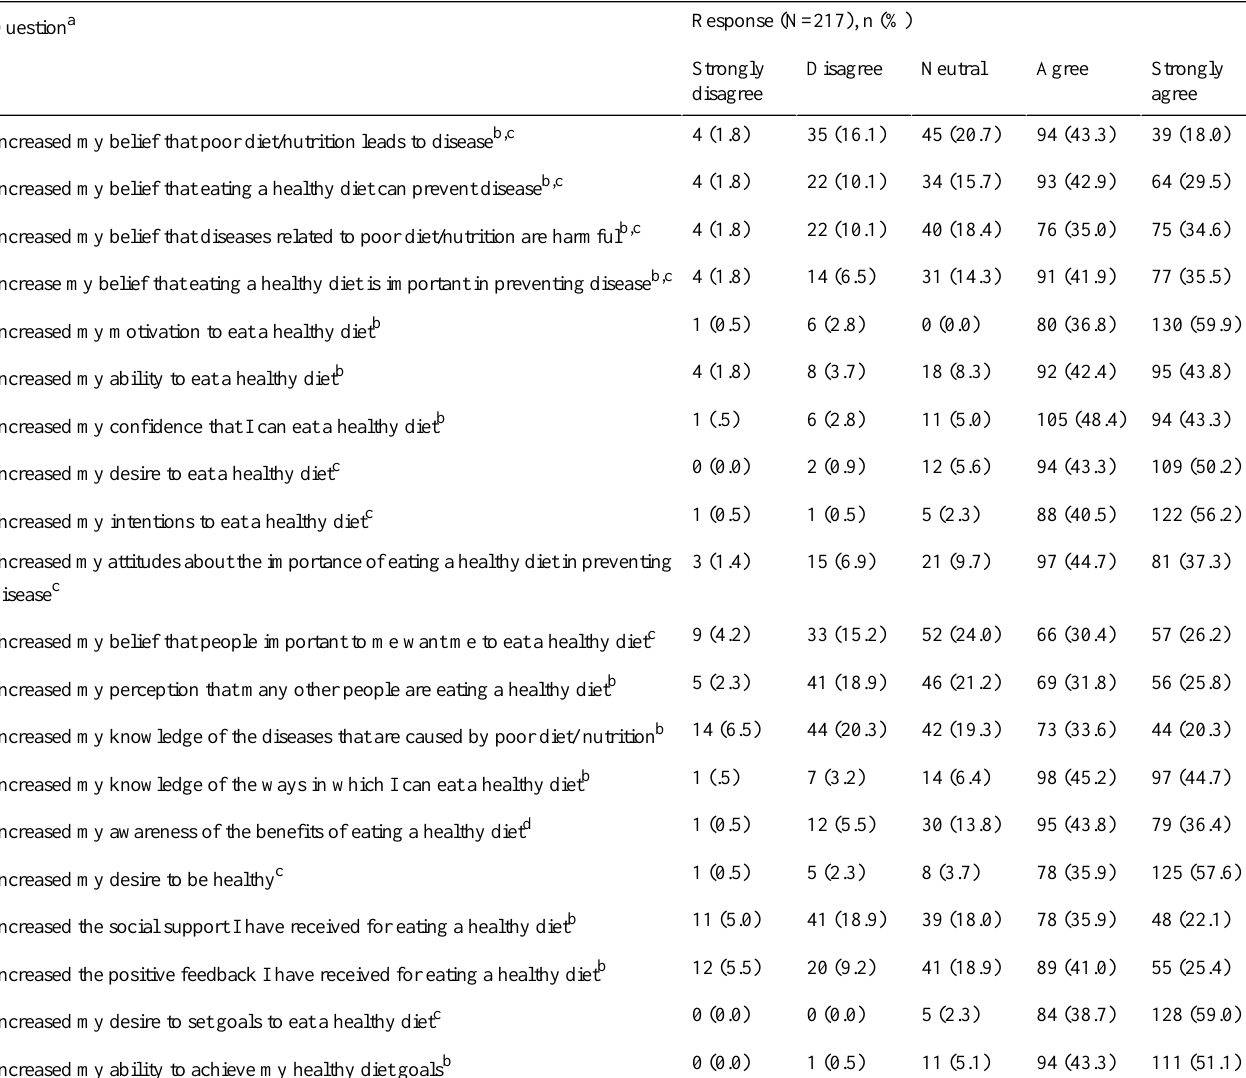
Table 2. Summary of participant reponses to theory questions.